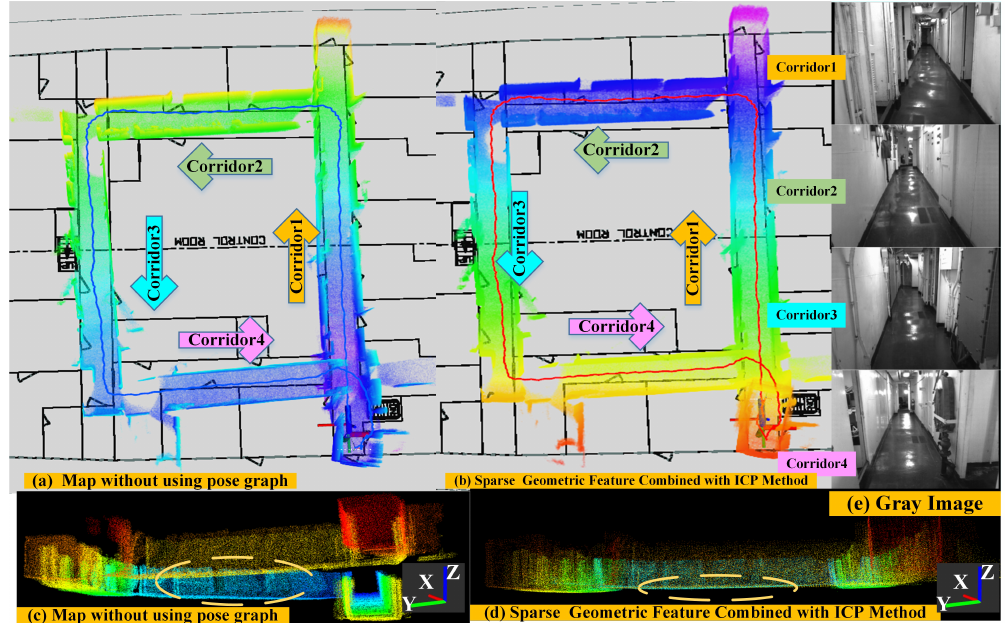
Figure 11. The accuracy comparison of mapping results between the front-end algorithm and back-end algorithm in overhead and front views (the yellow dashed circle denotes the main difference in global maps).